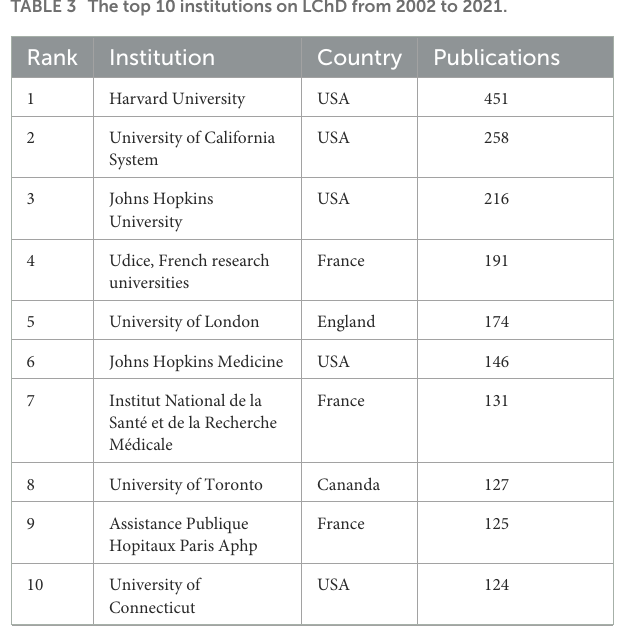
TABLE 3 The top 10 institutions on LChD from 2002 to